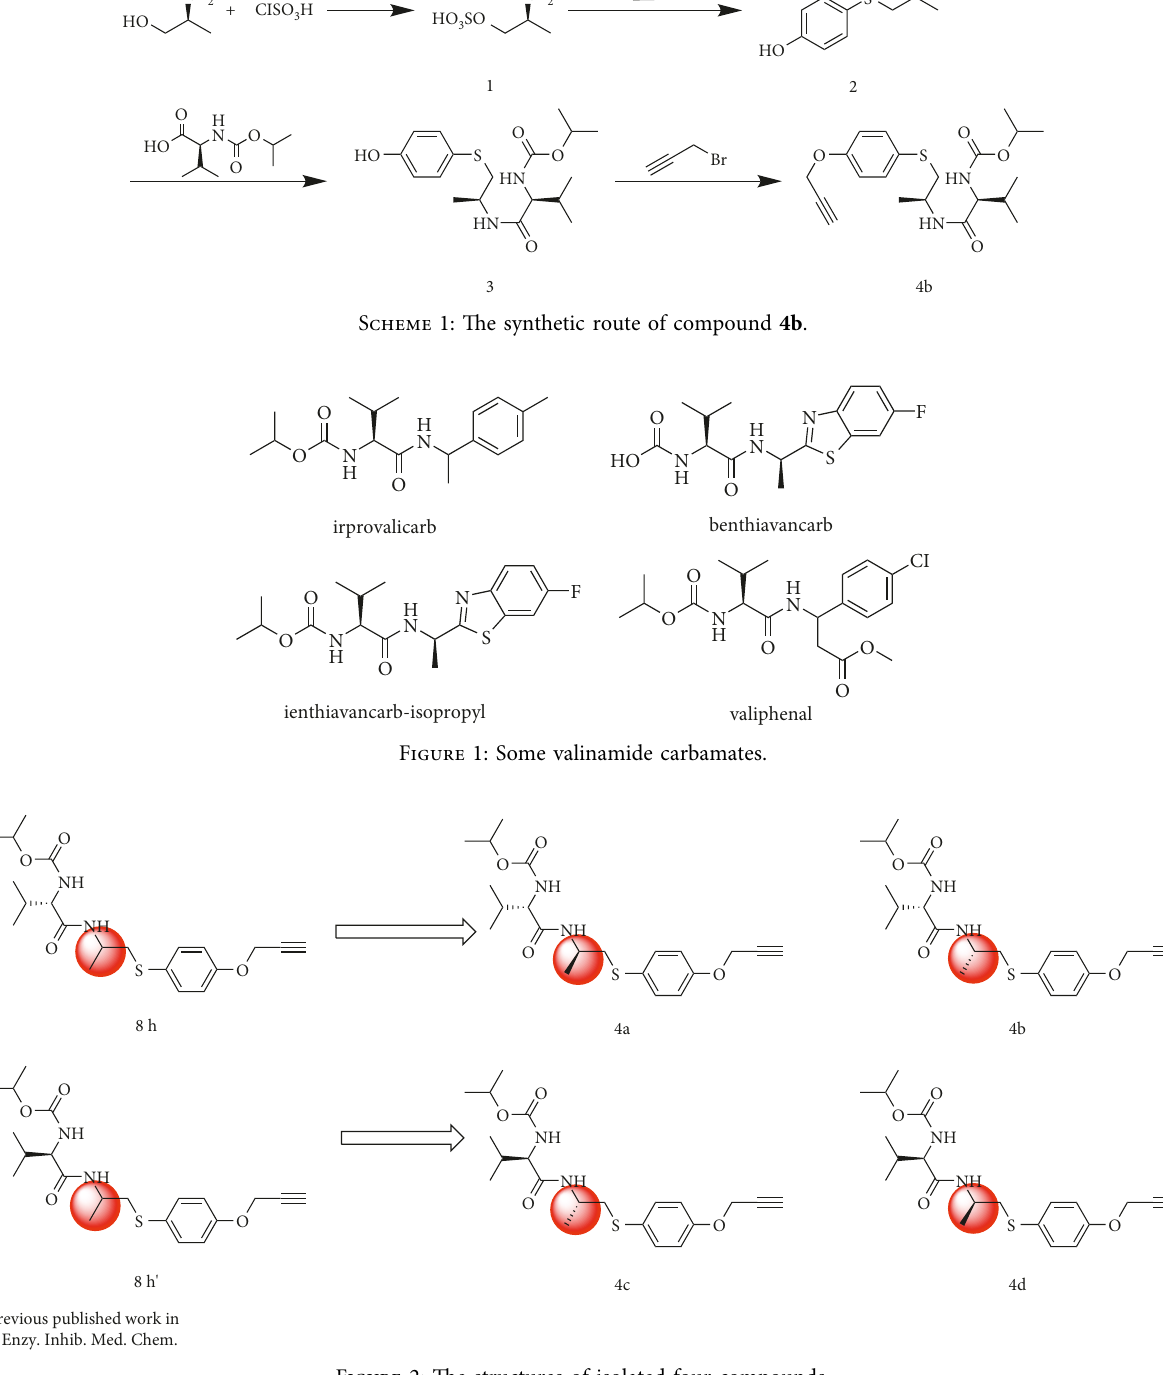
Figure 2: The structures of isolated four